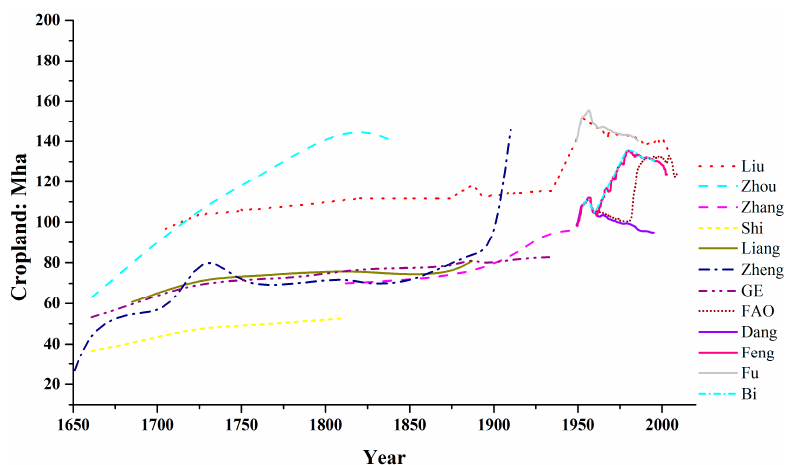
Figure 2. Historical changes of the cropland area. Data resources: Liu [23], Zhou [24], Zhang [17],